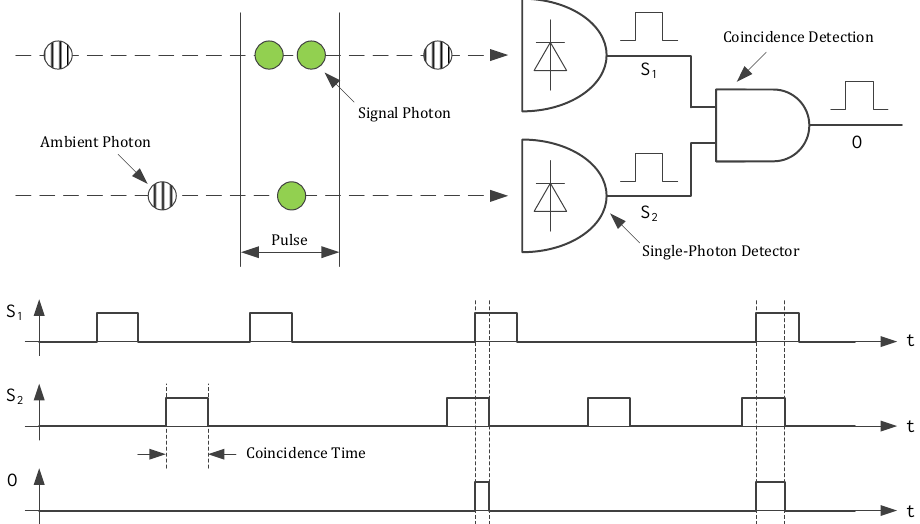
Figure 3. Simple circuit for the detection of photon coincidences. If the output pulses of the detectors with a width corresponding to the coincidence time overlap, a coincidence event is detected.